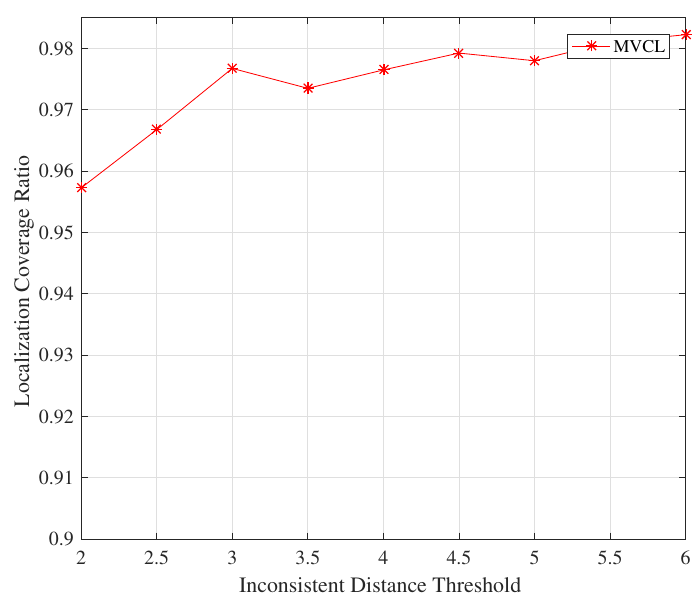
Figure 9. Localization coverage with inconsistent distance threshold η ( n = 80, m = 20, k = 4, R = 30, ζ = 15).